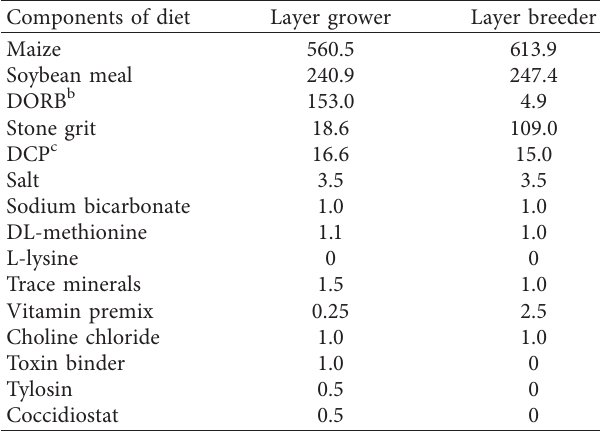
Table 1: Composition of feed (g/kg) for layers a . Components of